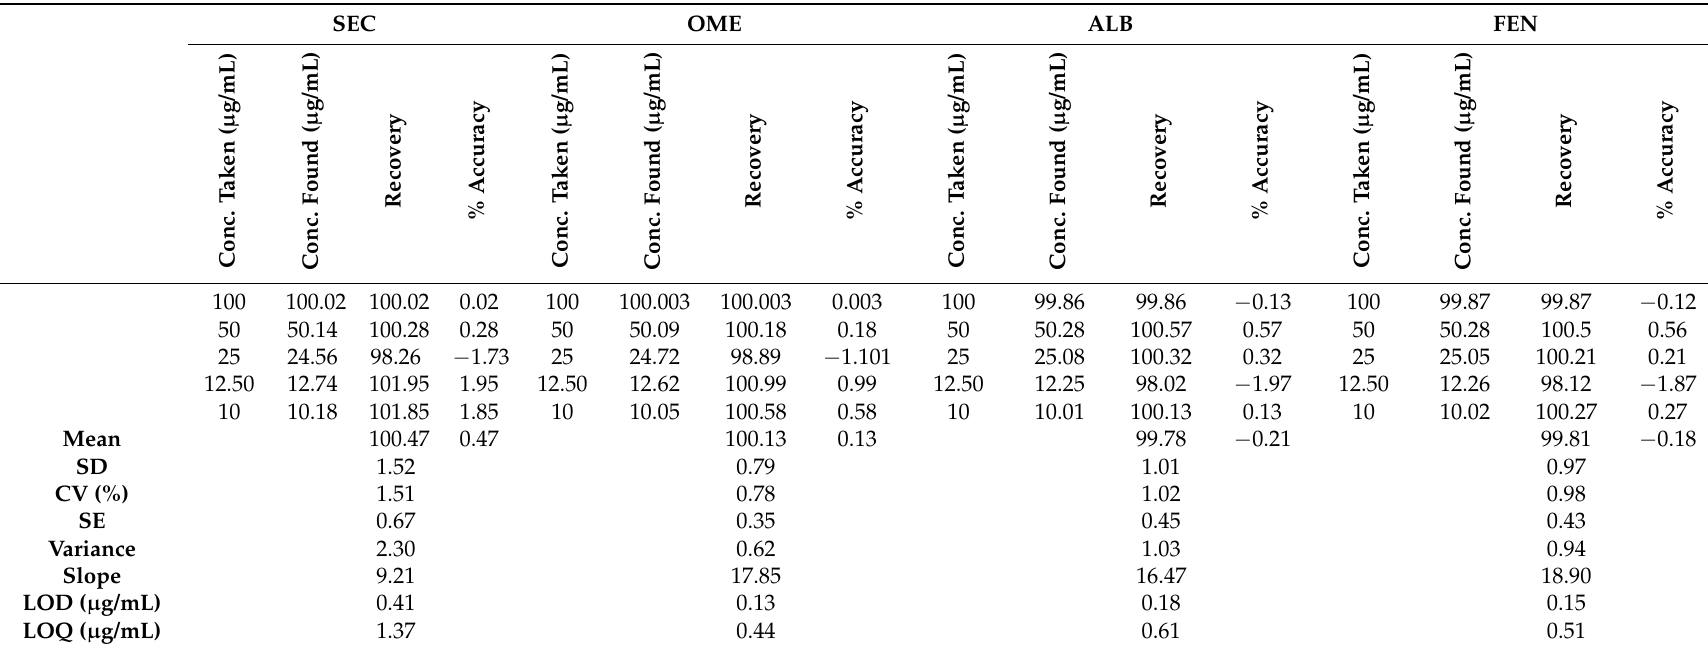
Table 3. Analytical merits for determination of SEC, OME, ALB, and FEN in pure samples using the proposed